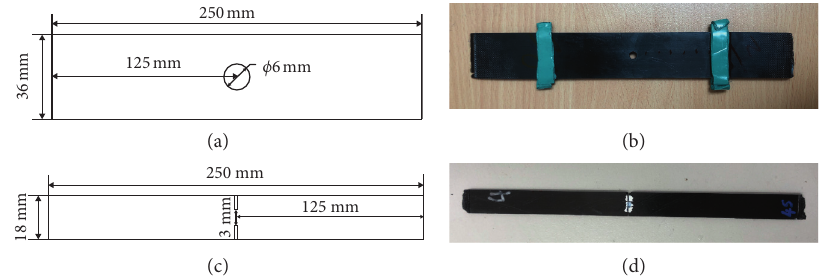
Figure 2: Test specimens. (a) Position of the hole in the specimen for tensile test. (b) Picture of specimen for tensile test. (c) Position of the cracks in the specimen for bending test. (d) Picture of specimen for bending test.